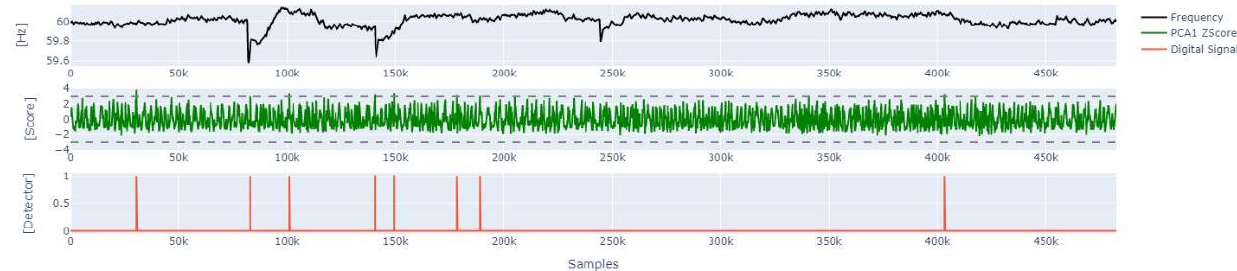
Figure 19. Event 2: detector event of PMU hydroelectric power station José Richa. Figure 20. Event 2: detector event of PMU hydroelectric power station Ney Braga.